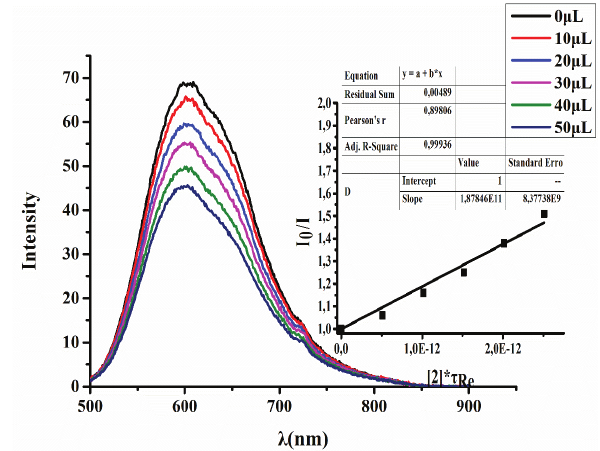
bpy] with added [ 2 ] in 3